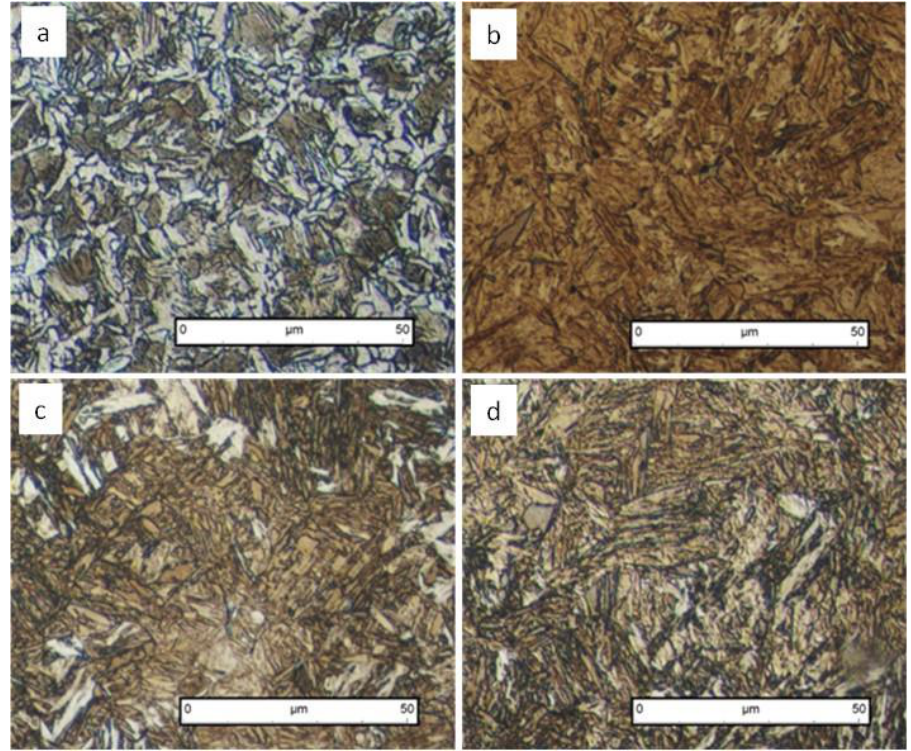
Figure 2. Typical quenching microstructures of C22E steel ( a ), C45E steel ( b ), 37Cr4 steel ( c ) and 40niCrMo6 steel ( d ).